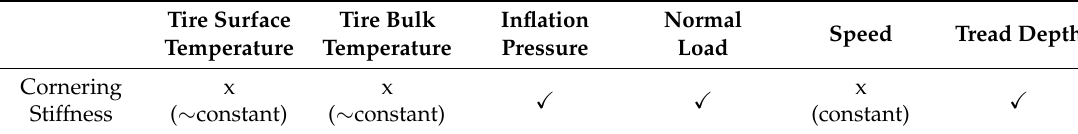
Table 4. Variable dependency